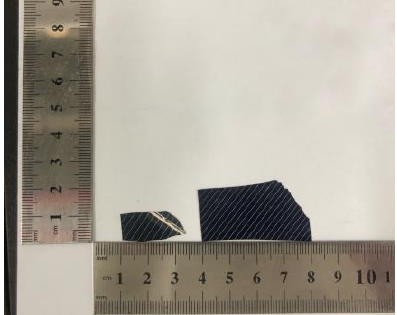
Figure 1. End-of-life photovoltaic cell sample.